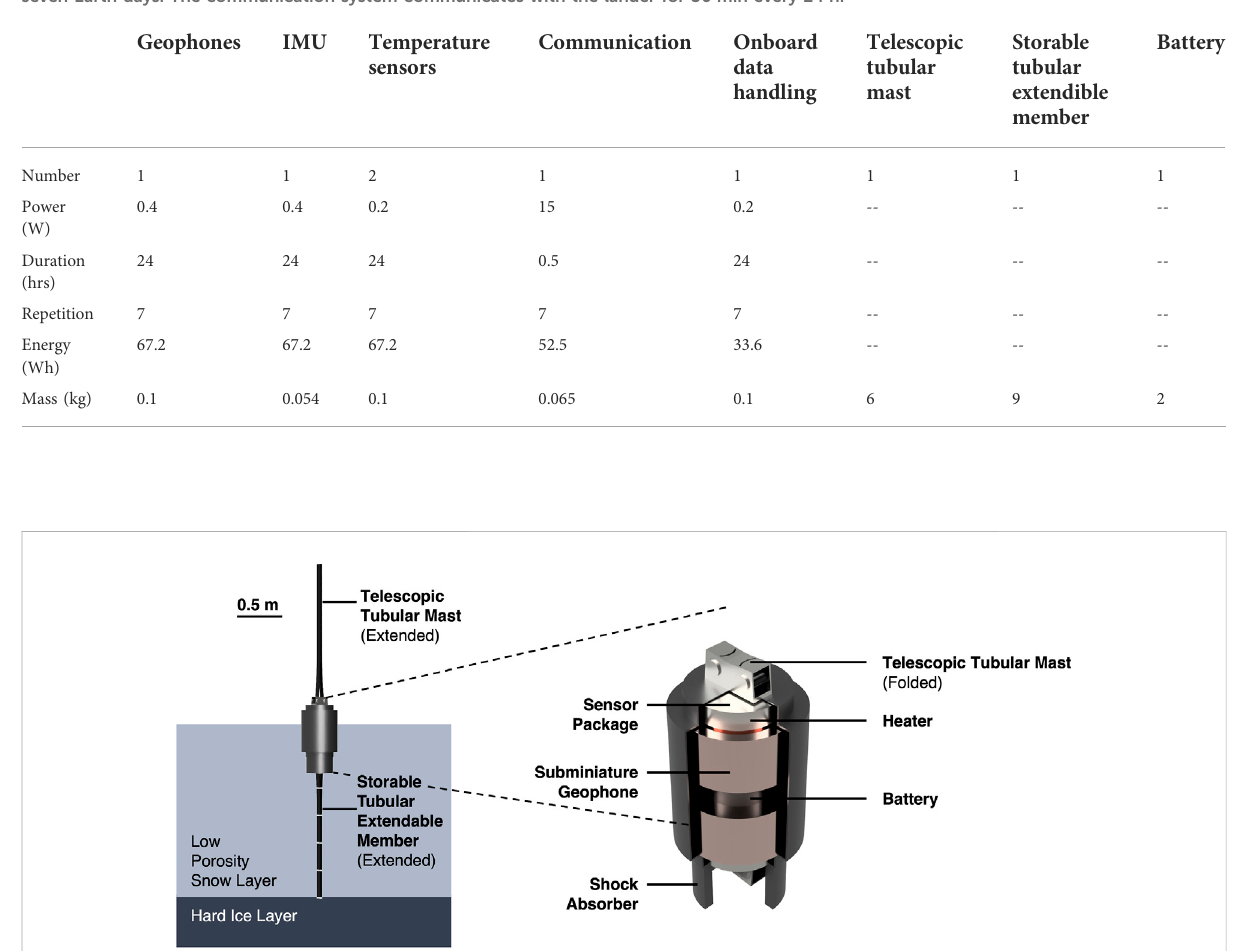
TABLE 6 Power and mass budget for a single SHOOC probe (note: ETNA includes three). The probe sensor suites and OBCs continuously operate for seven Earth days. The communication system communicates with the lander for 30 min every 24 h.